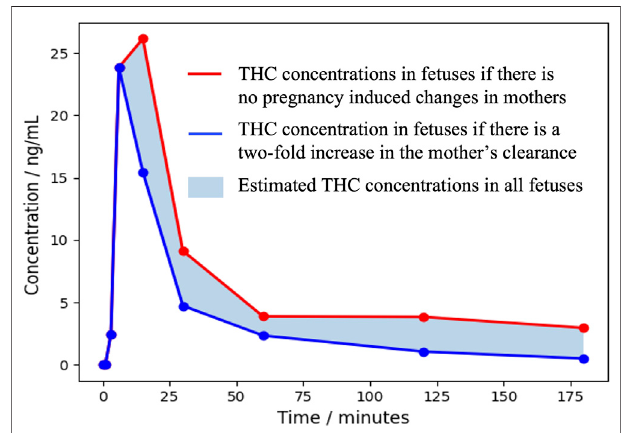
FIGURE 5 | Area of theoretical THC concentrations in fetuses over 3 h after a single 3.55% THC marijuana